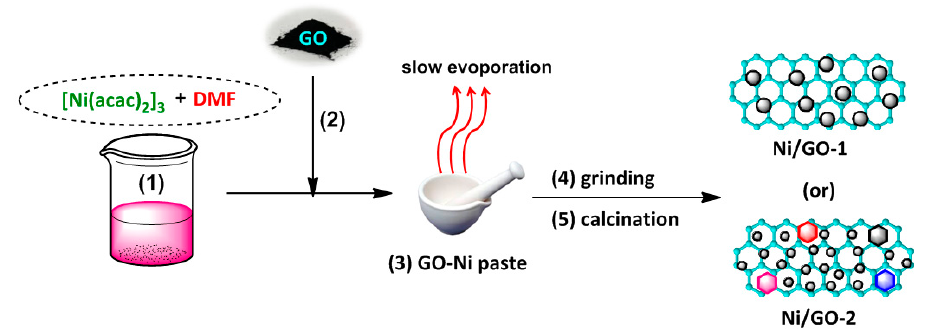
Figure 1. Schematic illustration for the preparation of Ni/GO-1 and Ni/GO-2.